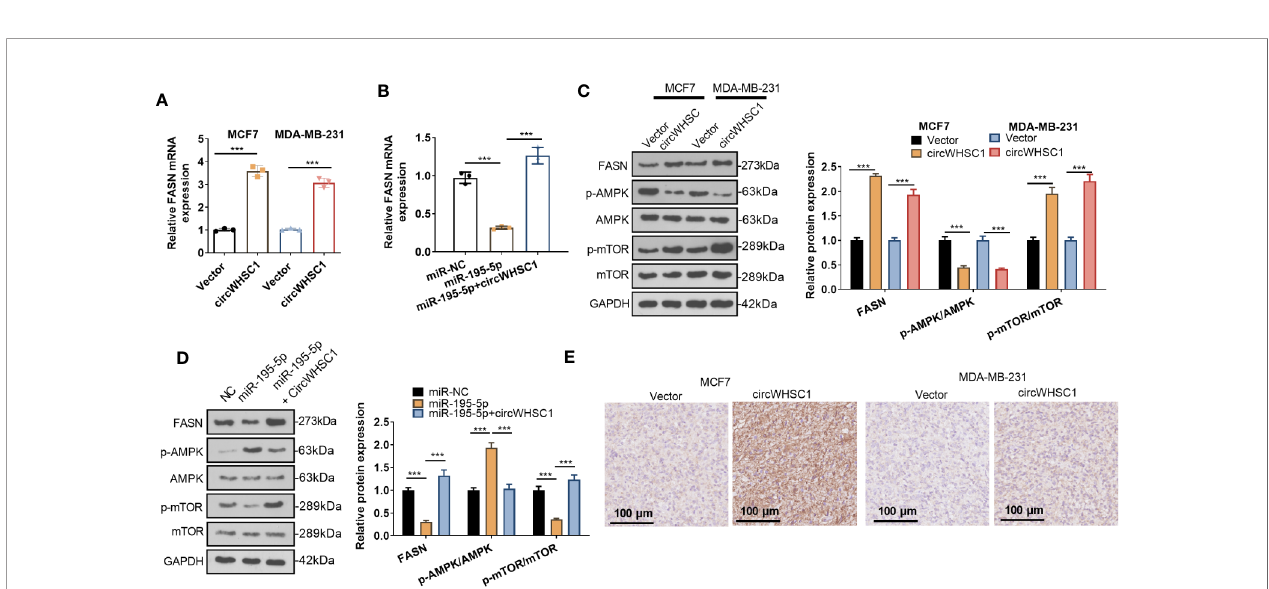
FIGURE 7 | CircWHSC1 and miR-195-5p regulated FASN. (A, B) qRT-PCR examined FASN mRNA expression in BC cells transfected with circWHSC1 overexpressing plasmids or miR-195-5p mimics. (C, D) WB tested FASN, AMPK and mTOR levels. (E) . IHC evaluated FASN in the tumor tissues formed by MCF7 and MDA-MB-231 cells transfected with vector or circWHSC1 overexpression plasmids. scale bar=100 m m. *** P < 0.001.